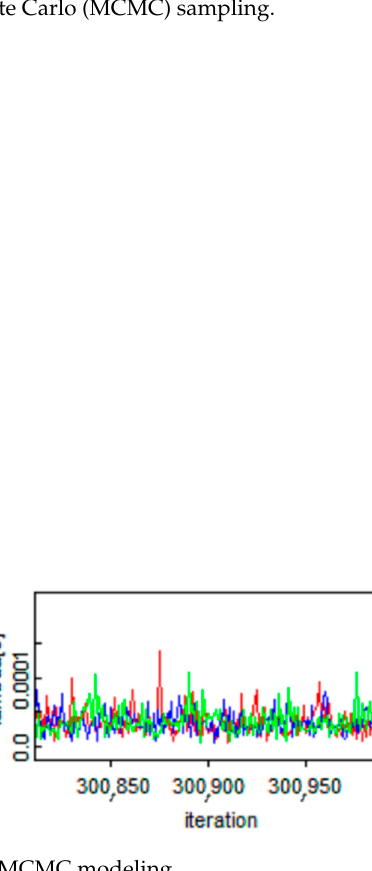
Figure 8. The dynamic trace of (cid:2019) in the MCMC modeling. A hierarchical Bayesian analysis was conducted using the data in Table 1. The poste- rior predictive distribution ( (cid:2019)) was estimated using (cid:2009) and (cid:2010), which are the shape and the scale parameters for each of the GRSs. The mean posterior value for hyperparameters (cid:2009) and (cid:2010) were 0.1315 and 1.236, respectively. The maximum failure probability was found for GRS 1 (6.45 × 10 (cid:2879)(cid:2873) ) , and the minimum probability was found for GRS 5 ( 1.25 × 10 (cid:2879)(cid:2874) ) . The estimated marginal posterior distributions for (cid:2009) , (cid:2010) , and (cid:2245) for the other GRSs are shown in Table 2. Table 2. The statistical properties of the posterior values of the hyperparameters and lambda. HBM Parameters